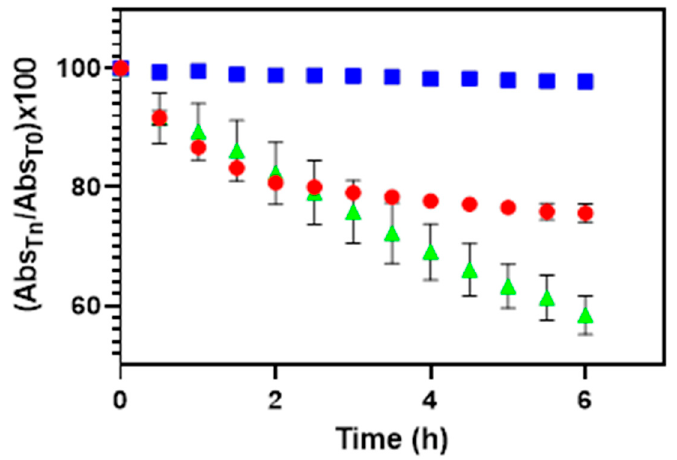
Figure 1. Stability evaluation of QRC expressed as percent of absorbance variation vs. time in: PBS 7.4 pH + DMSO ( ▲ ); citrate buffer 5.5 pH plus DMSO ( ● ); citrate buffer 5.5 pH plus DMSO and ACys ( ■ ).